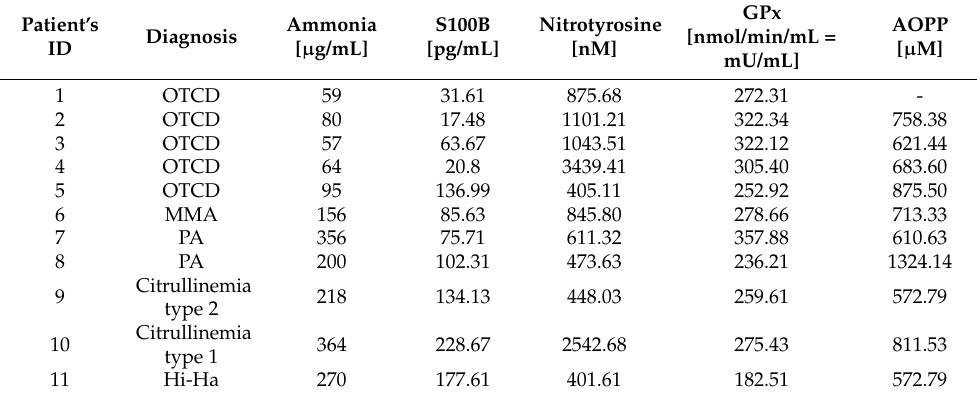
Table 2. S100B, 3-nitrotyrosine, AOPP concentration, and GPx activity in plasma 1 .